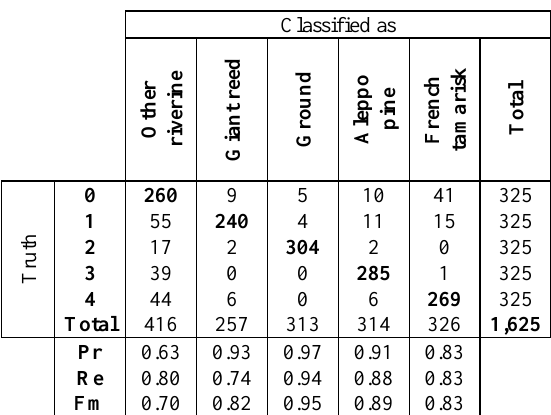
Table 3. Confusion matrix with precision (Pr), recall (Re) and F-measure (Fm) for the different classes analysed. Column headers are class labels, row names are respective class indices